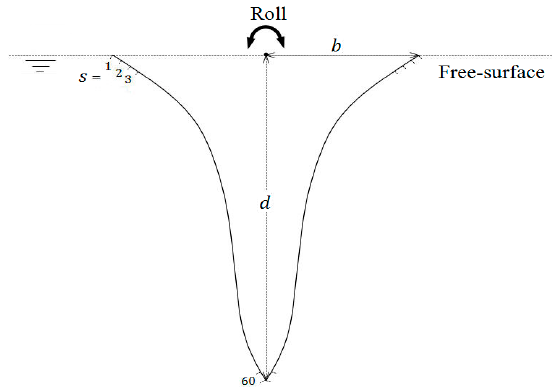
Figure 4. A hull section S22 with sharp keel [17] harmonically rolls on the water surface, with mean draught d = 9.5 m, half of mean breadth b = 4.5 m, roll frequencies ω = 0.4 ∼ 2.6 rad/s. Each side of the wetted surface is equally divided into 60 segments.